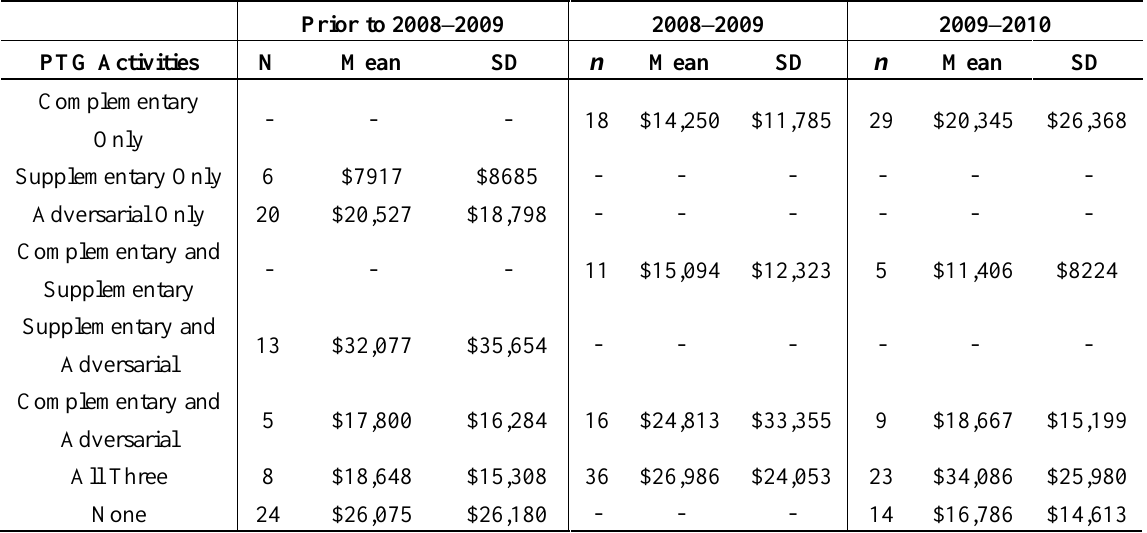
Table 3. Mean amount spent PTG spent on school by PTG activities and time